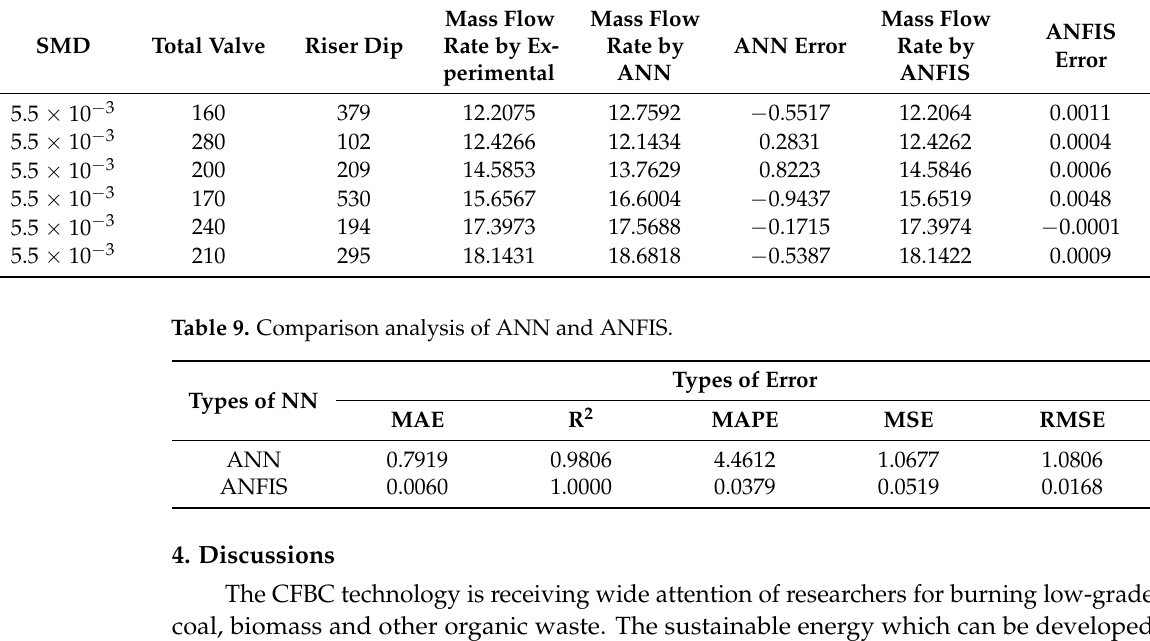
Figure 13. Error between Experimental and Predicted output of ANFIS.